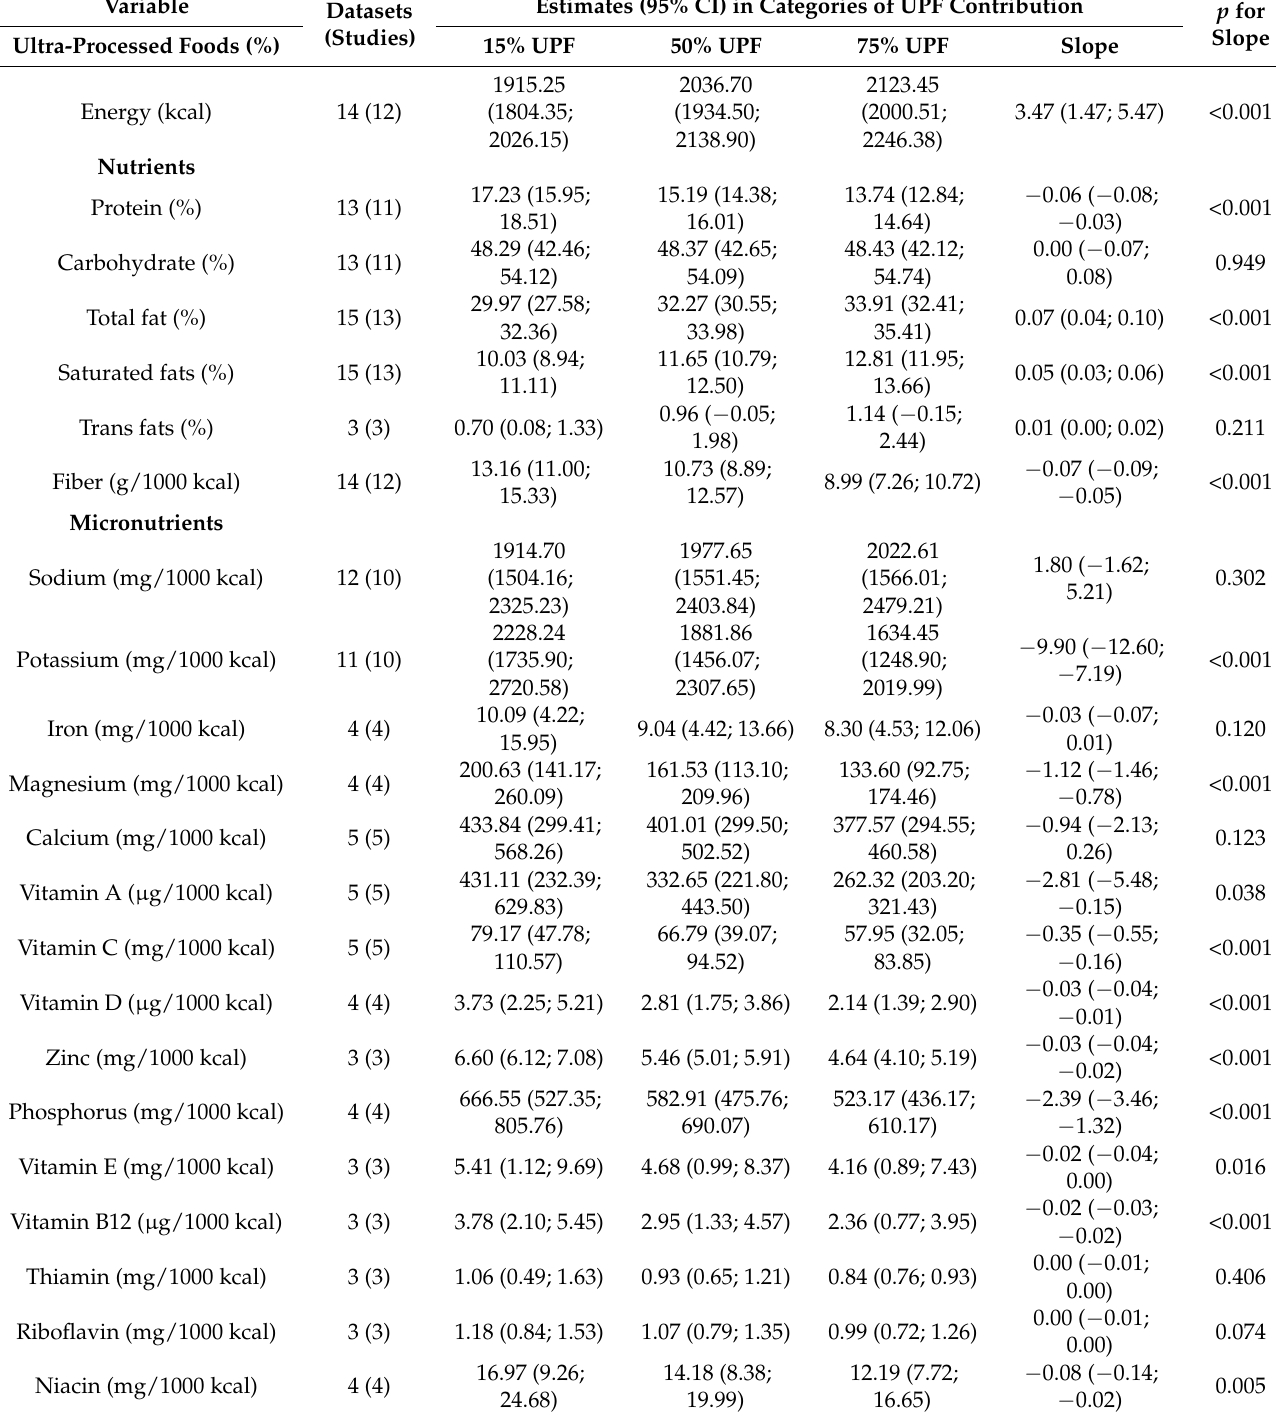
Table 3. Variation in specific nutrient intake by contribution of ultra-processed foods to total energy consumption and slope of nationally representative samples. Slopes represent the variation in intake of a specific food item when the share of %E from UPFs increased by